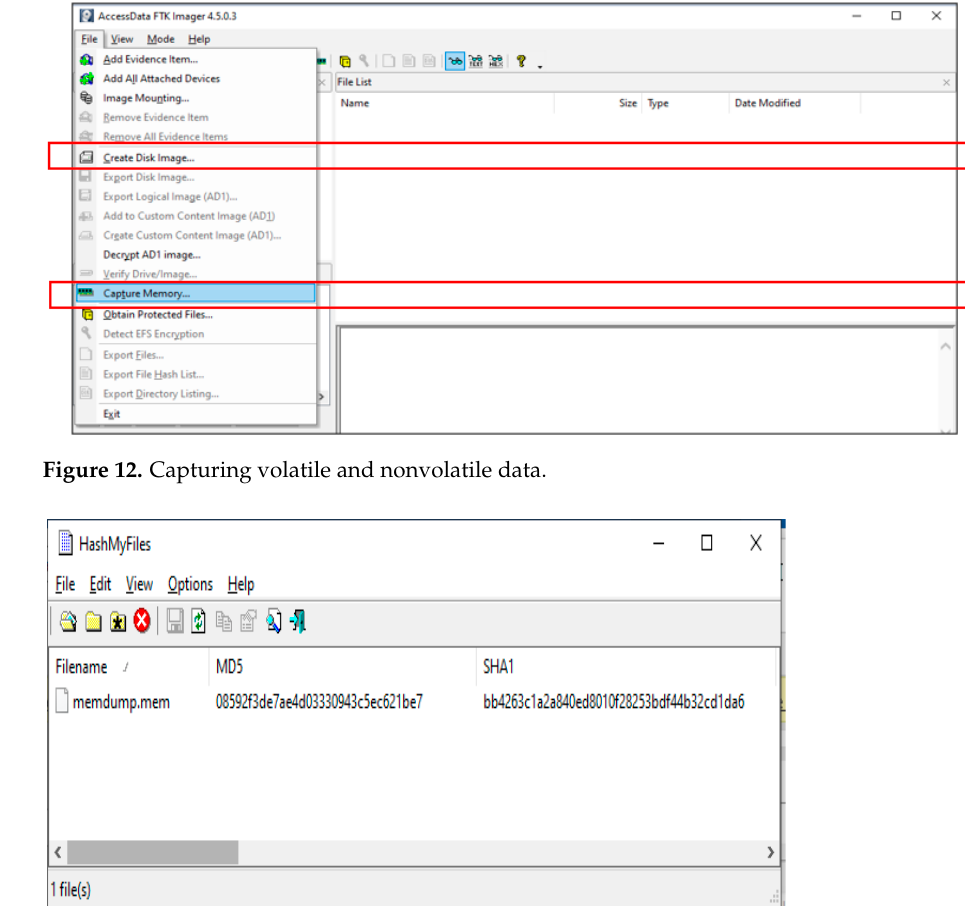
Figure 13. Hashing the captured data.